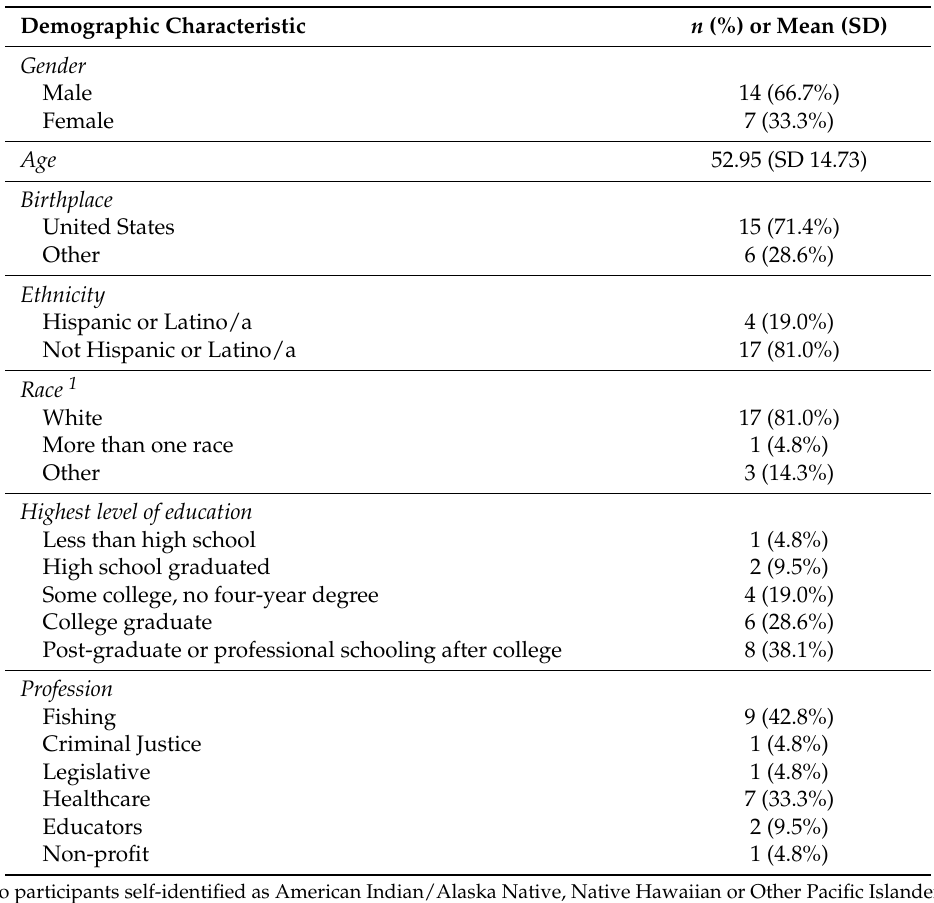
Table 2. Descriptive characteristics of study participants ( n =